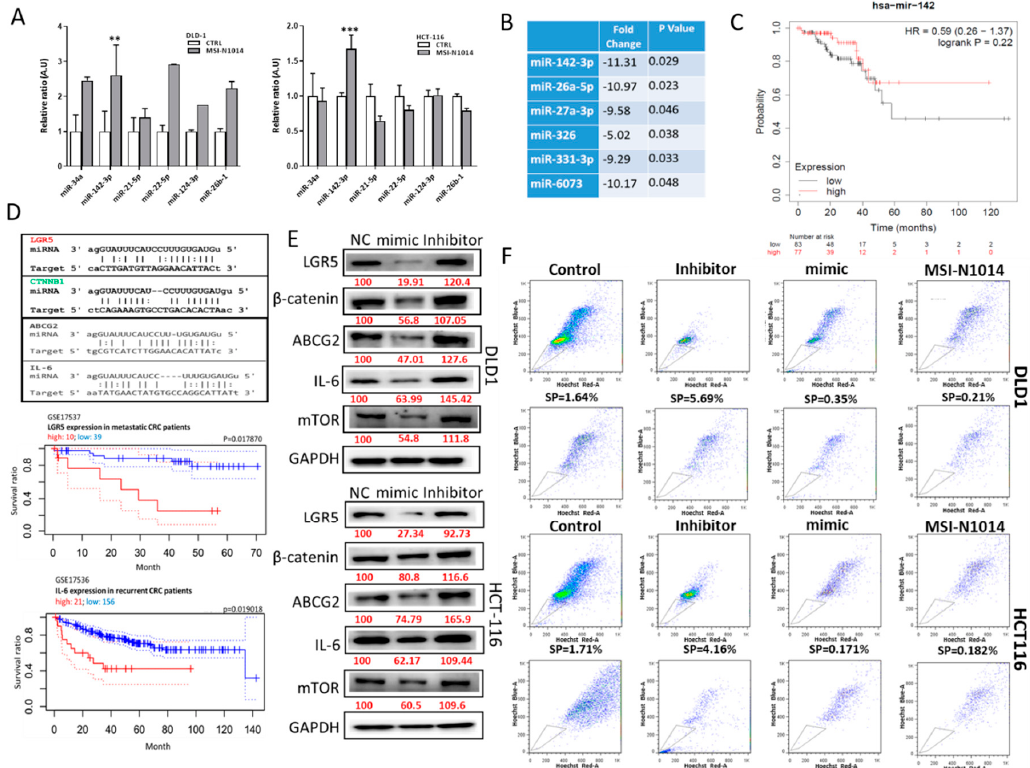
Figure 4. MSI-N1014 treatment induced the tumor suppressor, miR-142-3p. ( A ) Small-scale microRNA (miR) screening for MSI-N1014-treated colorectal cancer (CRC) cells. Among di ff erent miRs tested, the miR-142-3p level had significantly increased in both HCT116 and DLD1 cells after MSI-N1014 treatment. ( B ) Tabulated plasma miR profiles between CRC and normal samples [13]. A significantly reduced level of miR-142-3p in plasma collected from patients with CRC ( n = 61), compared to normal subjects ( n = 24) was identified. ( C ) Kaplan-Meier survival curve of a TCGA cohort suggested that a higher miR-142 was positively correlated ( p = 0.22) with a higher survival ratio in patients with CRC. ( D ) Table listing potential targets of miR-142-3p. Leucine-rich repeat-containing G-protein coupled receptor 5 (LGR5) was predicted and experimentally validated as a strong target for miR-142-3p, while CTNNB1 ( β -catenin), interleukin (IL)-6, and ATP-binding cassette super-family G member 2 (ABCG2) were also predicated targets for miR-142-3p. ( E ) Western blot analysis validating targets of miR-142-3p. Both DLD1 and HCT116 cells were transfected with miR-142-3p-mimic and inhibitor molecules. Mimic transfected samples showed markedly reduced expressions of LGR5, β -catenin, ABCG2, mammalian target of rapamycin (mTOR), and IL-6, while the opposite occurred in inhibitor-transfected samples. ( F ) Side-population (SP) flow cytometric assay. Percentages of SP cells were prominently reduced in miR-142-3p-transfected DLD1 and HCT116 cells, while they were increased in the inhibitor-transfected counterparts. Numbers in red indicate the relative expression ratio. ** p < 0.01, *** p <